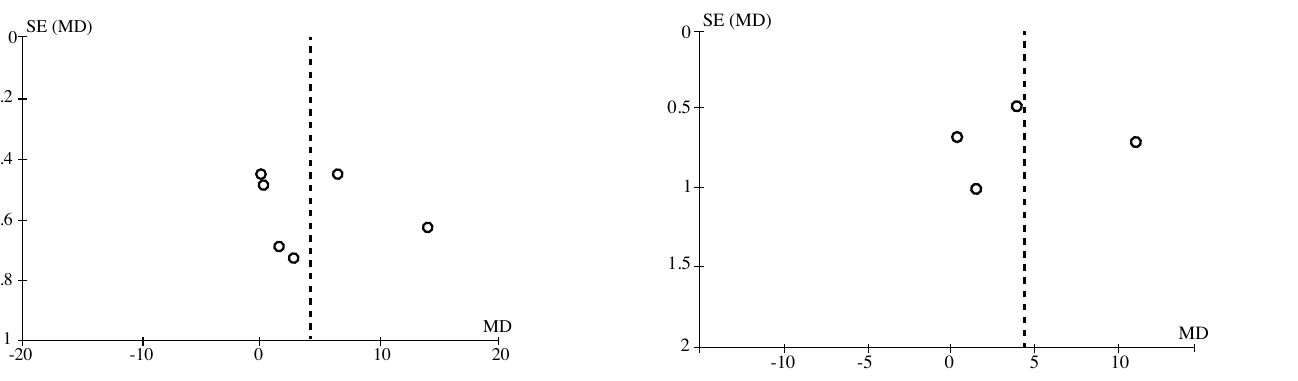
Figure 7. Funnel plot of the four results of the three studies selected for brachial biceps strength and endurance measured through the “Arm Flexion” (repetitions) test from the Rikli Jones test battery. Egger’s test was performed with bias = 22.796396 (95% CI = 16.748872 to